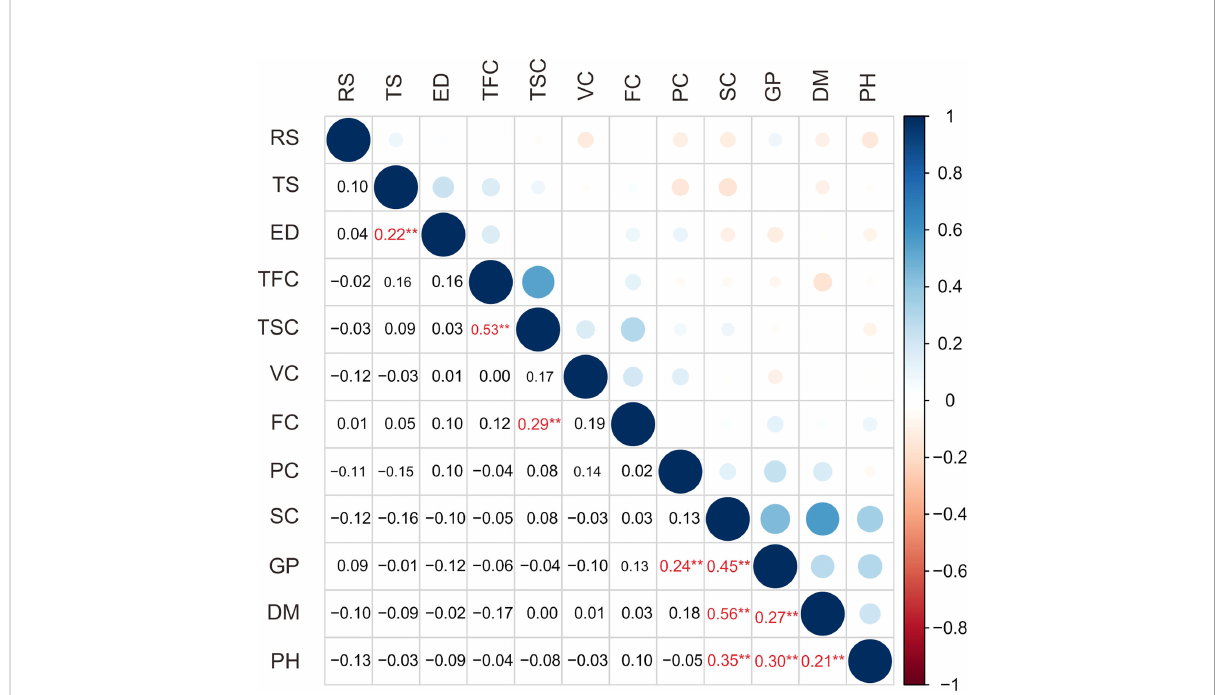
FIGURE 1 Correlation analysis of 12 traits of 149 potato cultivars. RS, reducing sugar content; TS, tuber shape; ED, eye depth; TFC, tuber fl esh color; TSC, tuber skin color; VC, vitamin C content; FC, fl ower color; PC, protein content; SC, starch content; GP, growth period; DM, dry matter content; PH, plant height. The numbers shown in red reach extremely signi fi cant correlation and are indicated with ** (P<0.01).